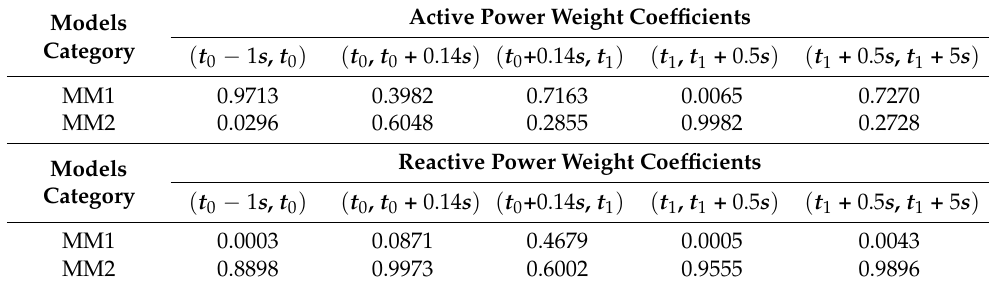
Table 1. Adaptive weight